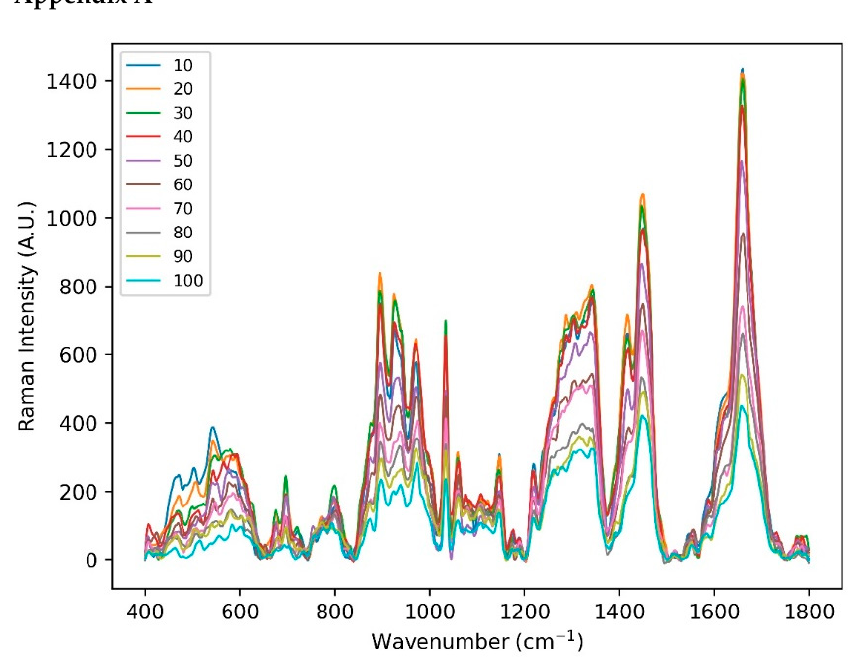
Figure A1. Raman spectral acquired from one of the healthy subject’s volar arm locations using handheld CRM system in the fingerprint region at 10 different depths (10 to 100 μ m).